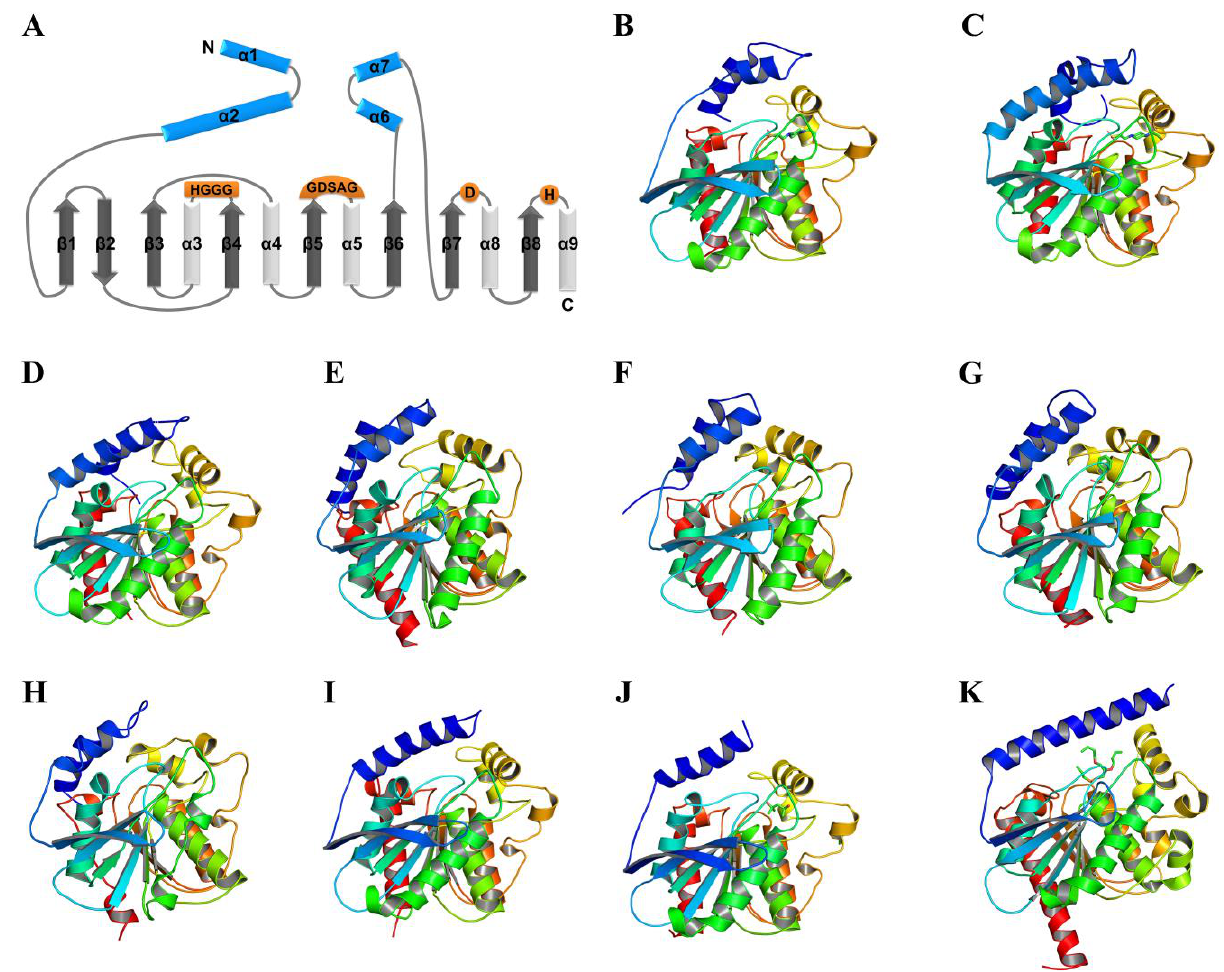
Figure 1. The overall structures of bacterial esterases belonging to the HSL family. ( A ) Secondary structures topology diagram of the HSL family. The α -helices and β -sheets are represented by cylinders and arrows, respectively. The catalytically core domain is shown in gray and white, and the additional modules are shown in blue. The locations of the conserved residues of the catalytic machinery are shown in orange. ( B ) The 3D structure of arylesterase EST2 (1EVQ) from A. acidocaldarius [27]. ( C ) The 3D structure of arylesterase AFEST (1JJI) from Archaeoglobus fulgidus [28]. ( D ) The 3D structure of the esterase PestE (2YH2) from Pyrobaculum calidifontis VA1 [29]. ( E ) The 3D structure of the esterase EstE7 (3DNM) from a metagenomic library [30]. ( F ) The 3D structure of the esterase E40 (4XVC) from a marine sedimental metagenomic library [31]. ( G ) The 3D structure of the esterase EstE5 (3FAK) from a soil metagenomic library [32]. ( H ) The 3D structure of the esterase EstD11 (7AT0) from a hot spring metagenomic library [21]. ( I ) The 3D structure of the esterase EstE1 (2C7B) from metagenomic library [33]. ( J ) The 3D structure of the esterase Sto-Est (3AIK) from Sulfolobus tokodaii 7 [34]. ( K ) The 3D structure of the esterase B (4PO3) from L. rhamnosus HN001 [26]. These structural images are generated using the software PyMOL [36].